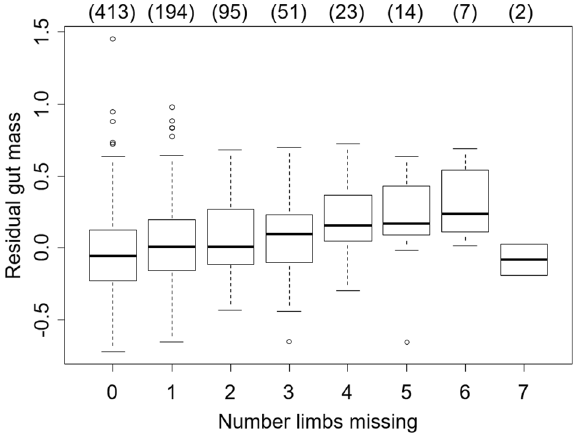
Figure 2. Residual gut mass, after accounting for body mass, of individual Hemigrapsus sanguineus sampled in 2020 as a function of the number of missing limbs. Box plots show median values (solid line), first to third quartile of the data (box), 95% of the data (whiskers), and outliers that fall outside this range (circles). Numbers in parenthesis across the top show the sample size in each category.